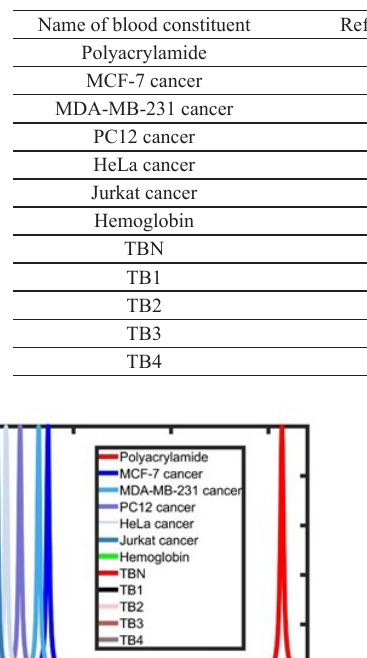
Table 1. The refractive index of different blood constituents 33,38 .